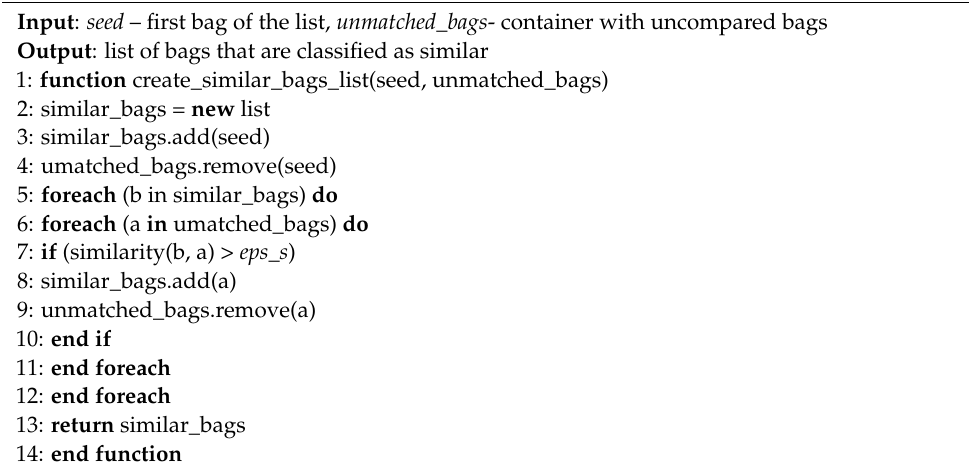
Algorithm 3: Creating one set containing bags classified as